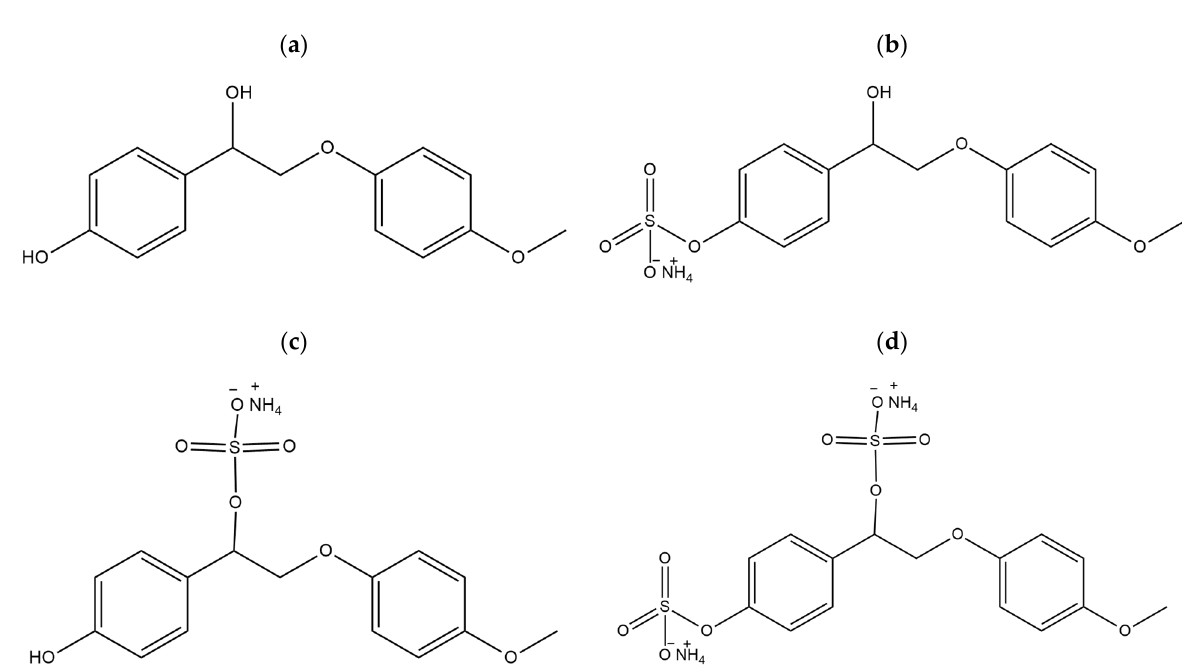
Figure 7. Investigated β -O-4 lignin molecules: initial β -O-4 lignin ( a ), and sulfated β -O-4 lignin with the sulfate group localized at the aromatic ( b ), alkyl ( c ), and alkyl and aromatic ( d ) hydroxo groups.